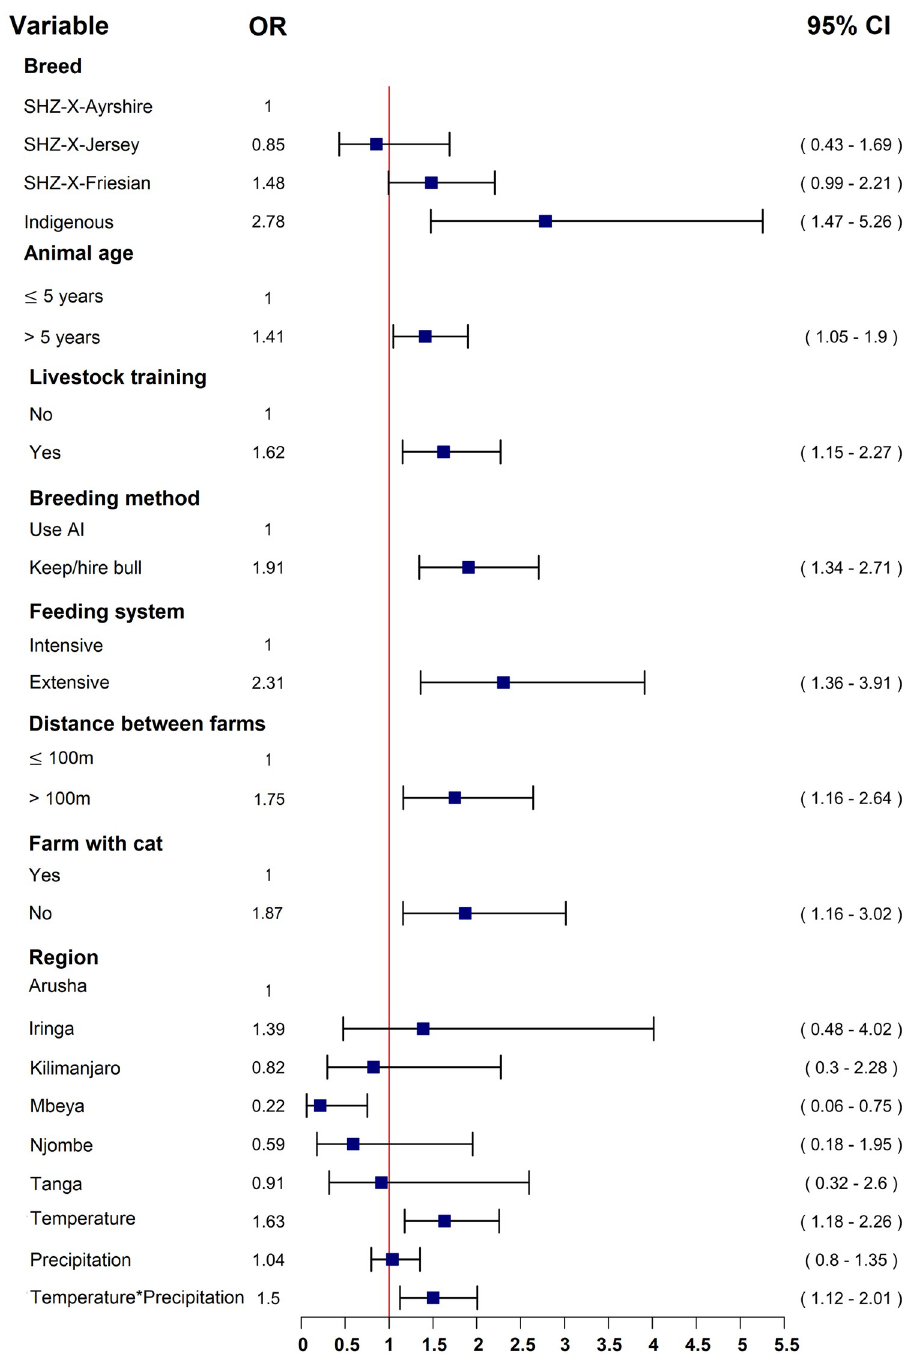
Fig 3. A forest plot summarizing the final multivariable model of significant predictive variables for leptospirosis association to seropositive occurrence in smallholder Tanzanian dairy cattle. 1.36–3.91) and more than 100 meters distance between the farms (OR = 1.75, 95%CI 1.16– 2.64). Increase in temperature (OR = 1.63, 95% CI 1.18–2.26), and the interaction between increased temperature and precipitation (OR = 1.50, 95%CI 1.12–2.01) were also found to be significant risk factors (Figs 3 and 4).